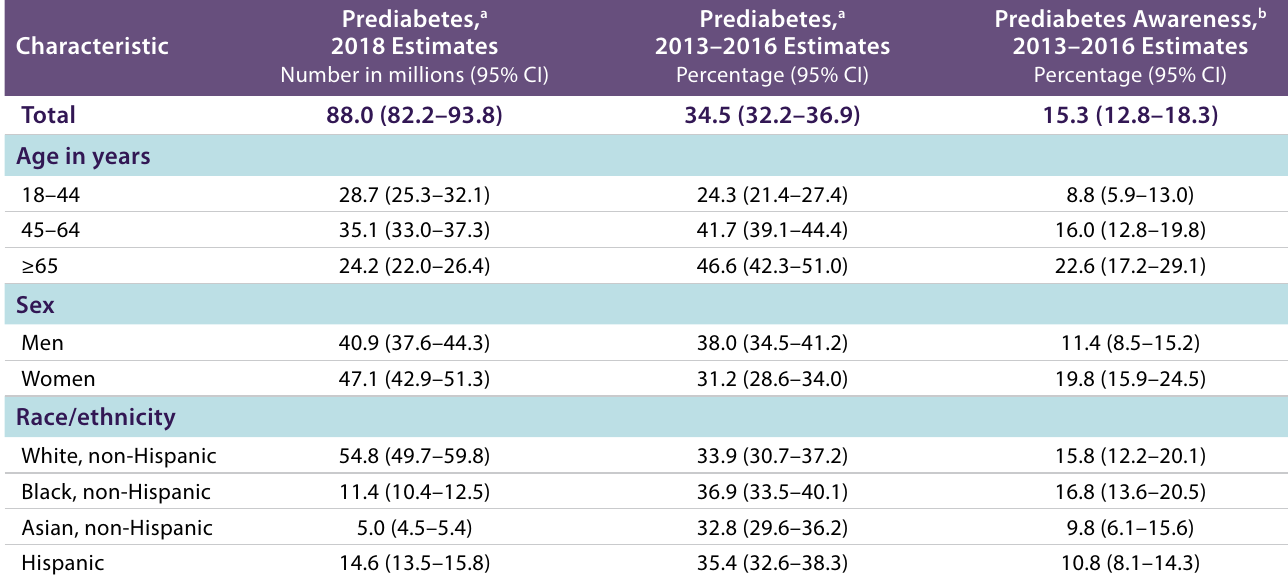
Table 3. Estimated number, percentage, and awareness of prediabetes a among adults aged 18 years or